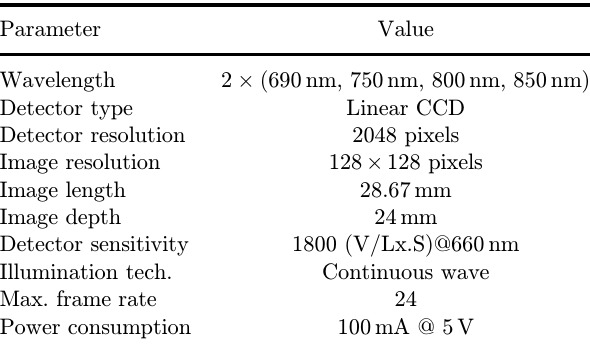
Table 1. DOB-Scan Probe characteristics and parameter.